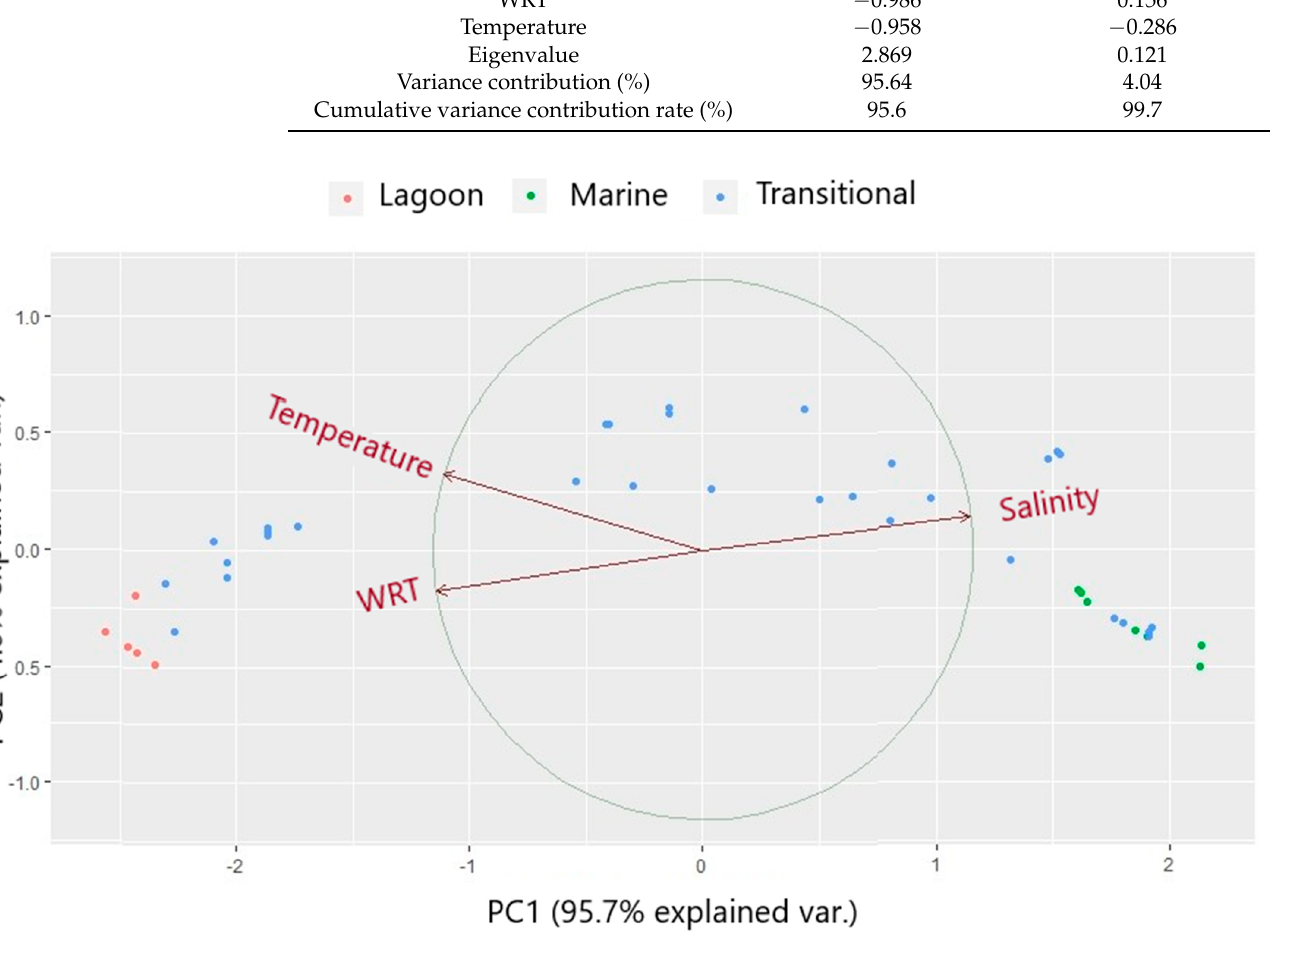
Figure 8. Biplots and distribution of sampling locations across the first two axes of principal components. Colors represent the assignment of sampling points to benthic zonation according to [26].